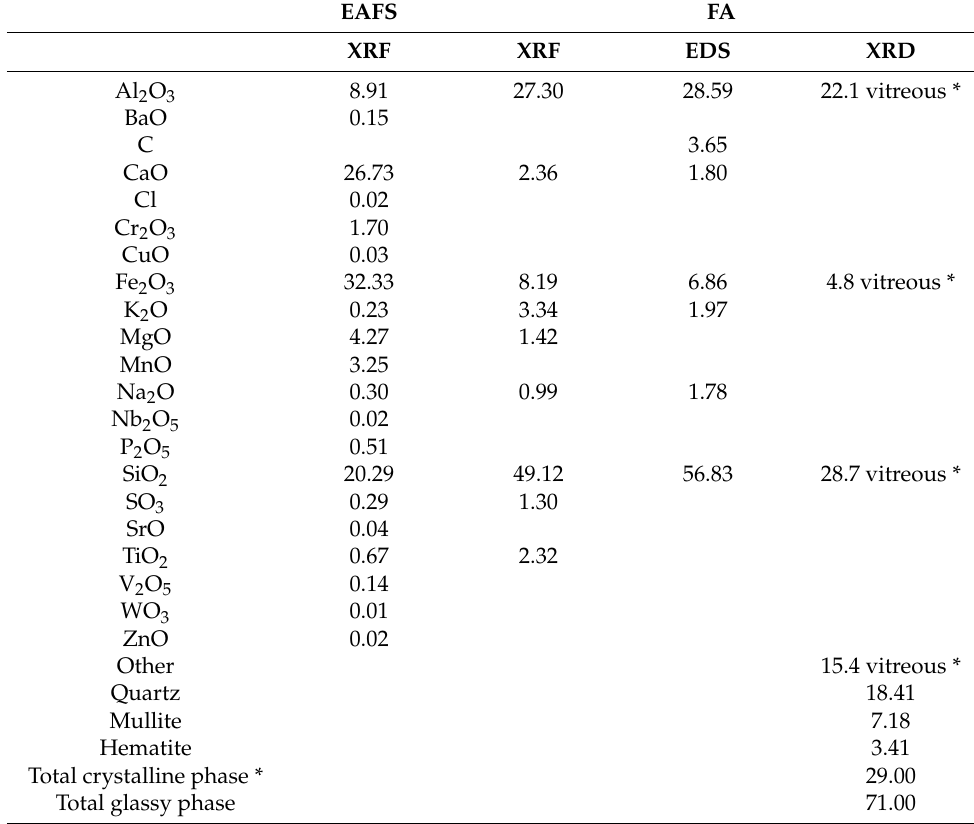
Table 3. Element composition of the EAFS and FA by XRF, SEM-EDS and XRD analysis [%].